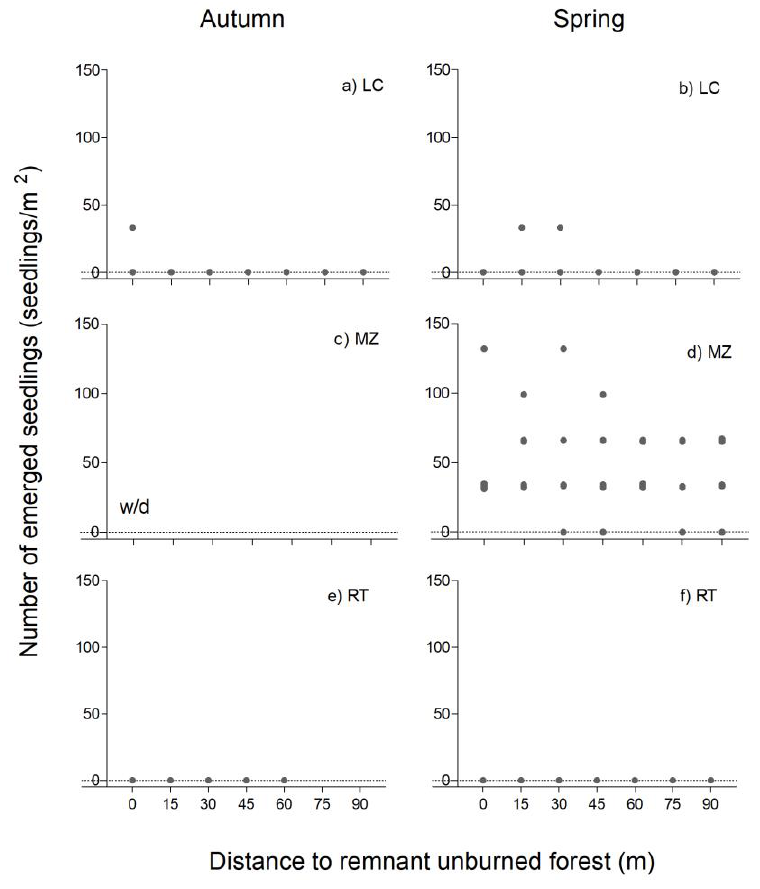
Figure 6. Grass emergence in La Colisi ó n (LC, ( a , b )) and Monte Zeballos (MZ, ( c , d )), and R í o Turbio (RT, ( e , f )), as a function of the distance from the edge of the remnant forest to the burned area, in autumn (left) and spring (right). Dots represent the observed emergence in each sample soil. w/d: without data.